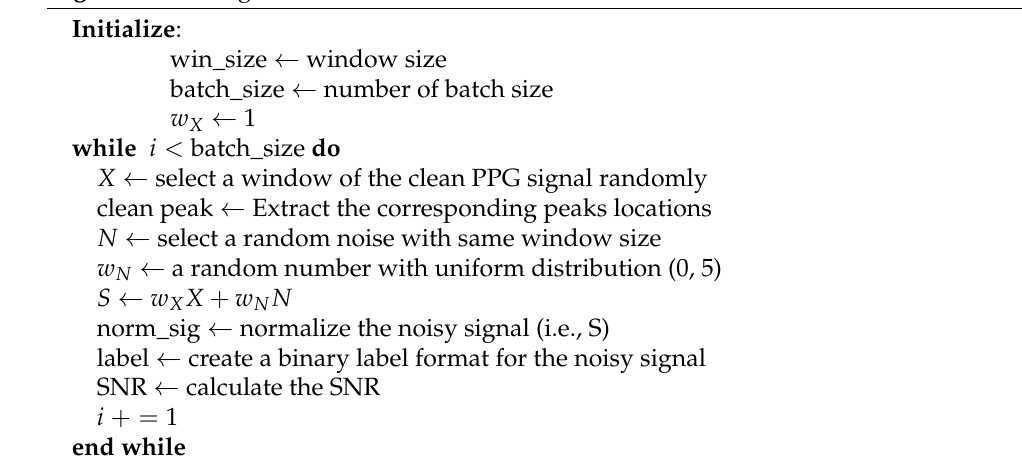
Algorithm 1 The generator